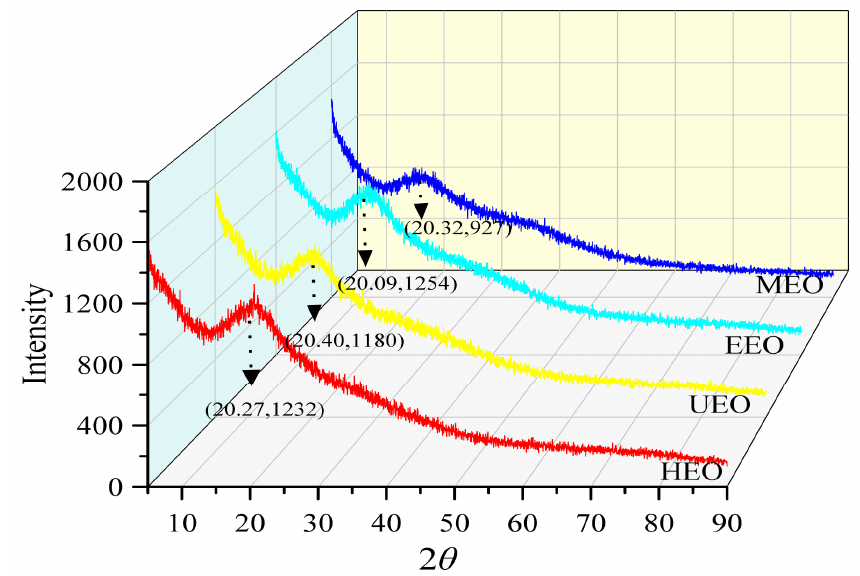
Figure 5. XRD (X-ray diffraction) pattern analysis of EOs.